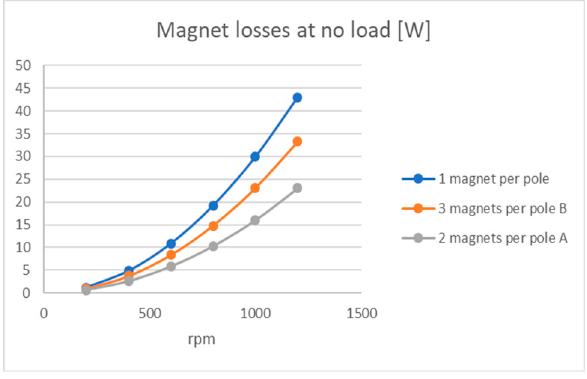
Figure 6. Magnet losses under no load for a 1.4 kW machine, Q = 12, p = 10 (simulation results).